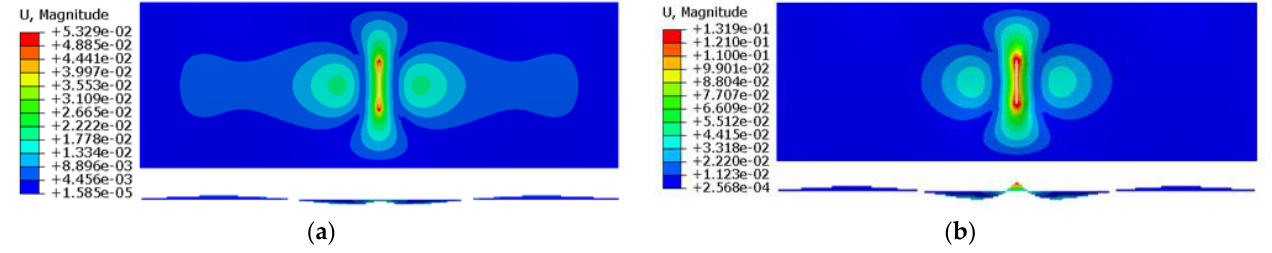
Figure 14. Out-of-plane deformation distribution of cracked plate at minimum load: ( a ) 𝑃 = 0.7𝜎 𝑢 , ∆𝑐 = 90 mm ; ( b ) 𝑃 = 0.9𝜎 𝑢 , ∆𝑐 = 90 mm .